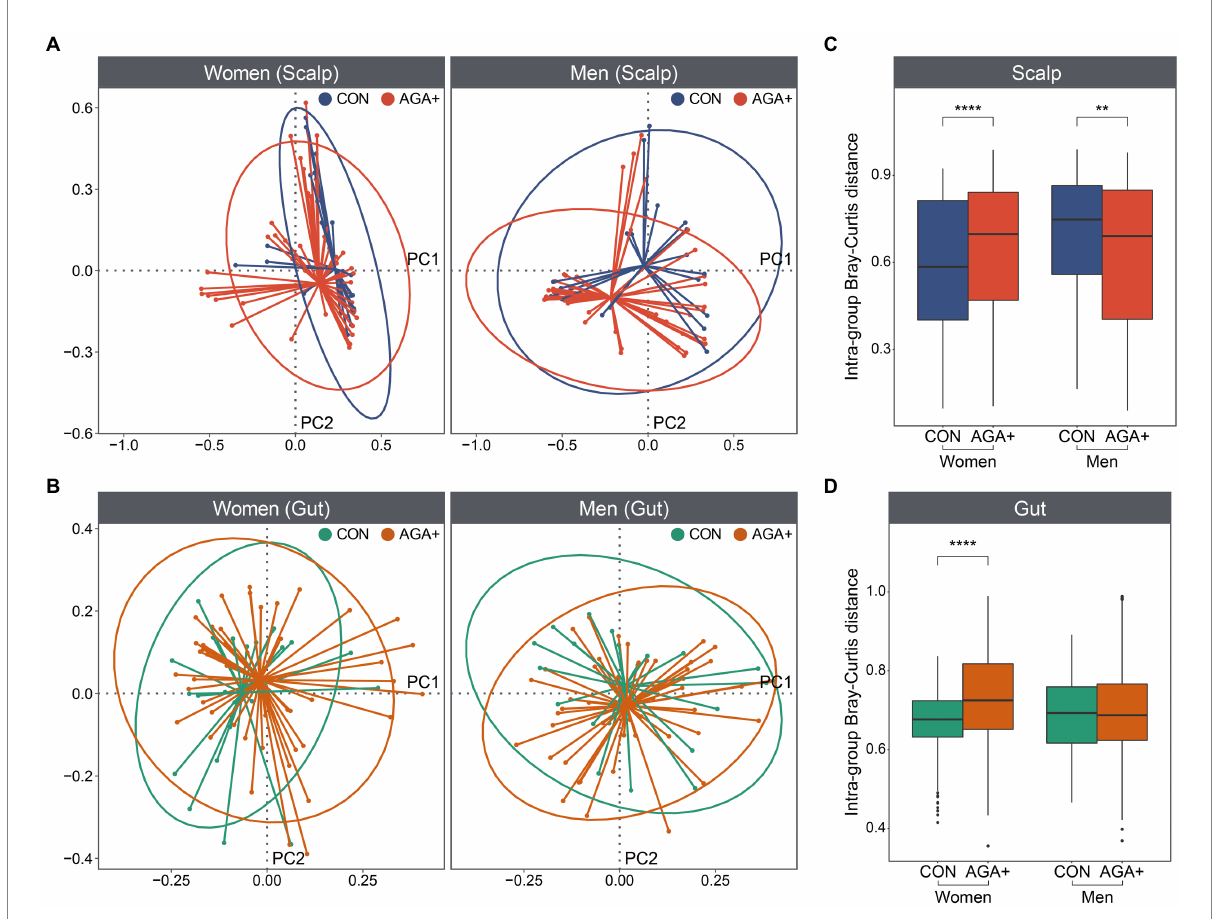
FIGURE 3 Beta diversity of scalp and gut microbiome. Principal coordinates analysis plot (based on Bray–Curtis distances) of the (A) scalp and (B) gut microbiome of healthy controls (CON) and individuals with AGA (AGA+). Ellipses represent a 95% confidence interval level for each group. The average Bray–Curtis distances between samples within each group in scalp (C) and gut (D) microbiome are shown in the